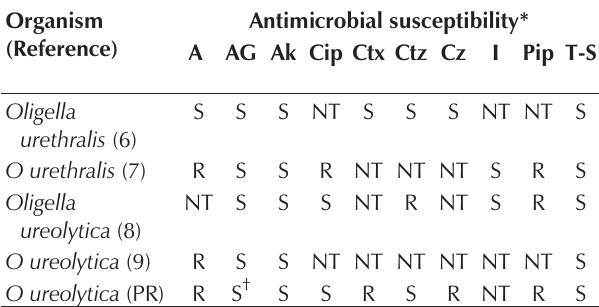
TABLE 2 Antimicrobial susceptibilities of Oligella species Organism